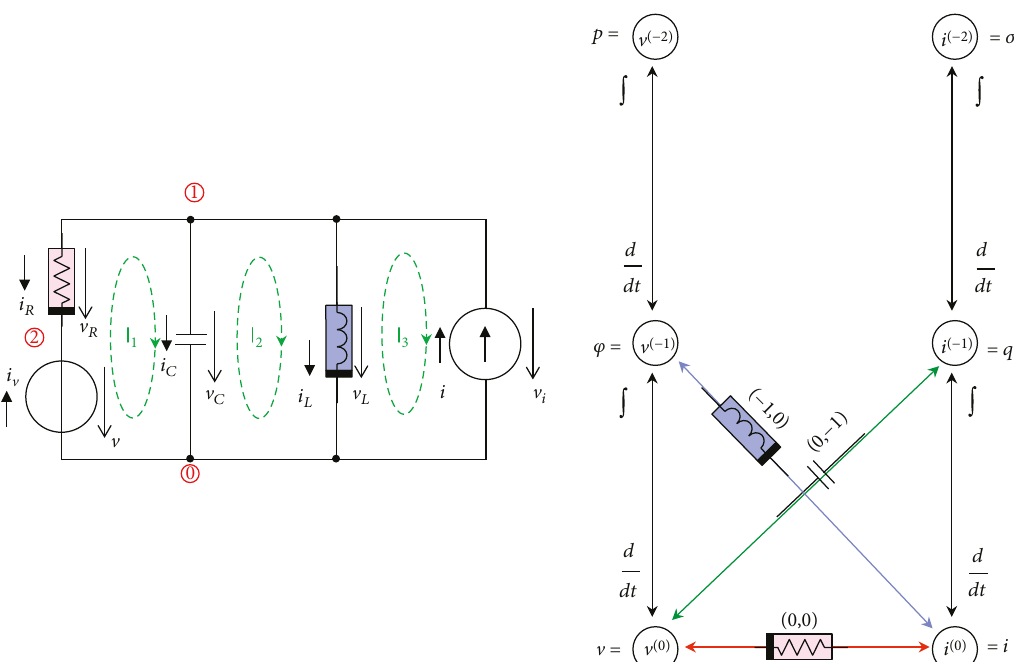
Figure 6: Dual circuit to the circuit in Figure 2 after shifting all the elements of the original circuit in the storeyed structure one fl oor down. The linear capacitor need not be moved, since its constitutive relation is invariant as regards vertical shifts.